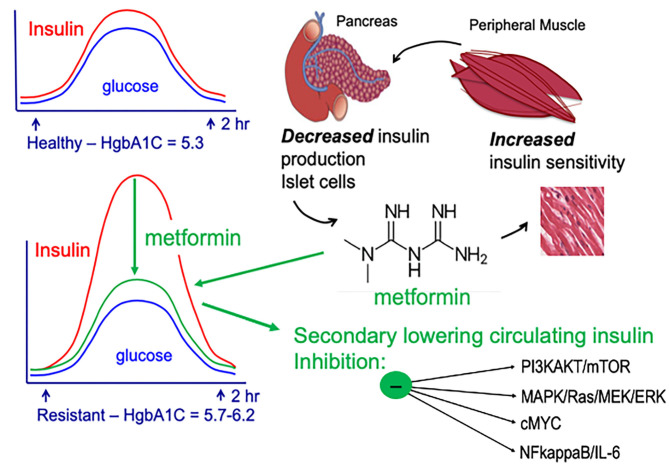
AMPK-dependent and AMPK-independent metformin signaling. Adapted from (42).